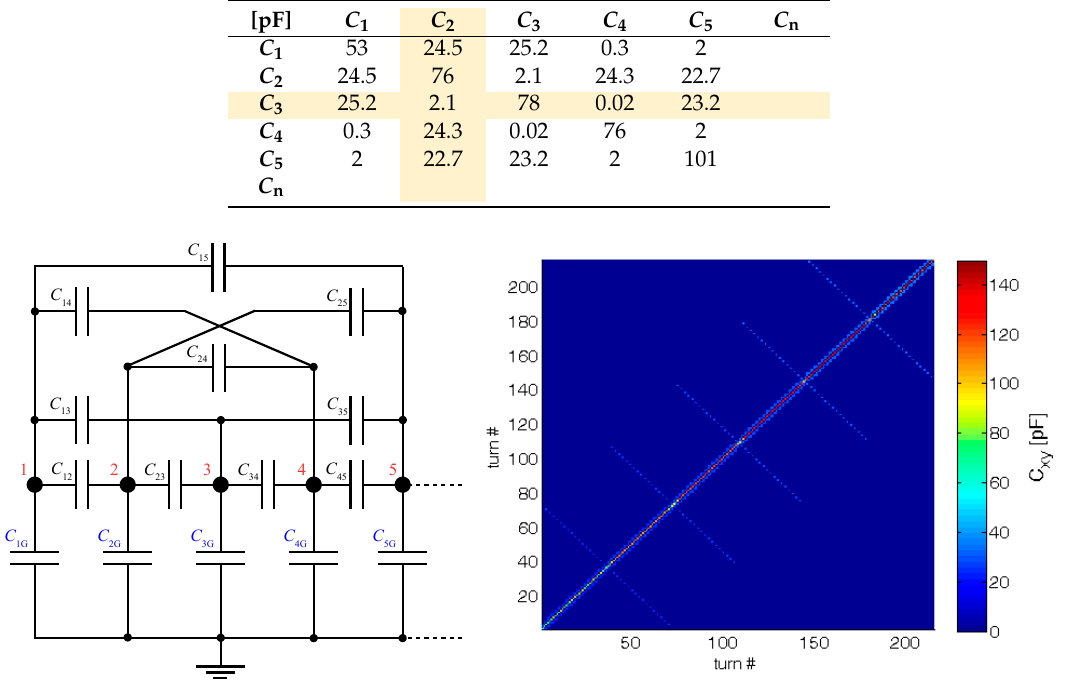
Figure 11. Equivalent model (node-to-node lumped capacitance network) for the first five turns of the winding ( left ); complete capacitance matrix expressed as a 3D plot ( right ).